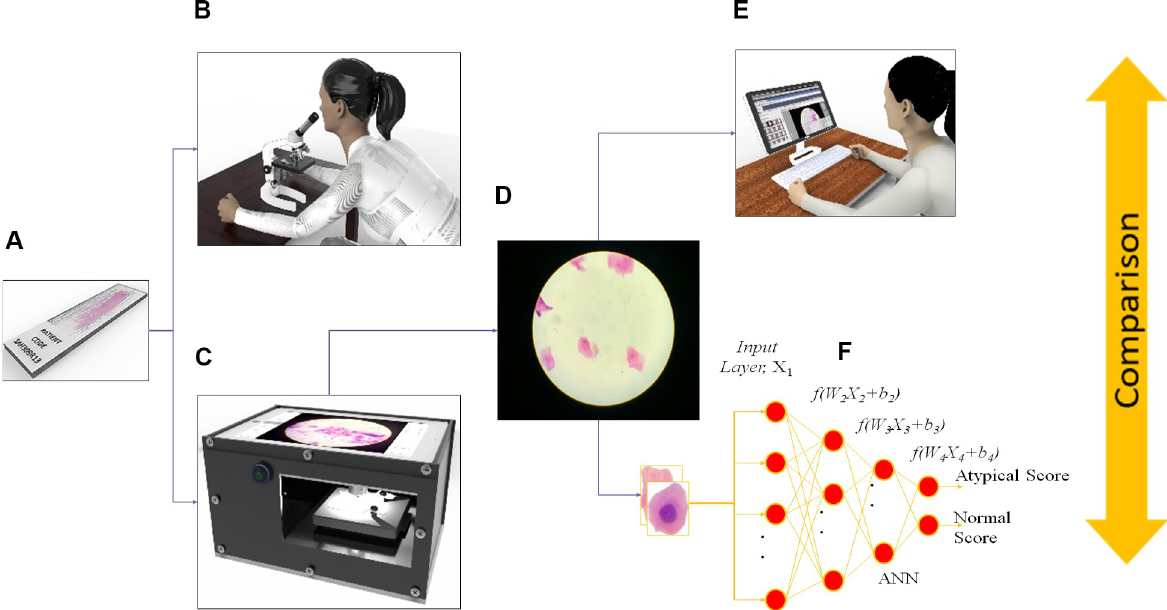
Fig 1. Study design. Microscopic slides were prepared (a) using liquid based cytology and slides were reviewed by (b) conventional direct microscopy. Images were captured using CellScope (c) and sent to remote server (d). Tele-cytology diagnosis (f) were performed by pathologist. Image pre-processing algorithm were developed, and ANN based cytology diagnostic platform were developed (g) and validated. Conventional cytology diagnosis, tele-cytology diagnosis and ANN based diagnosis were compared with histopathology.